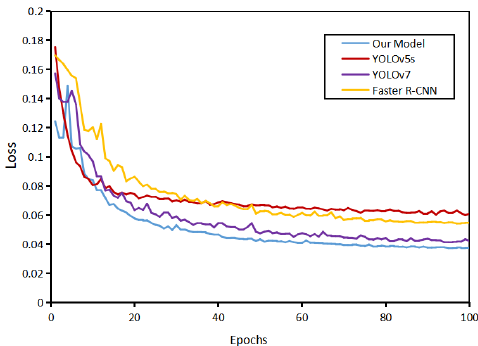
Figure 15. Comparison of model loss curves on the testing data.